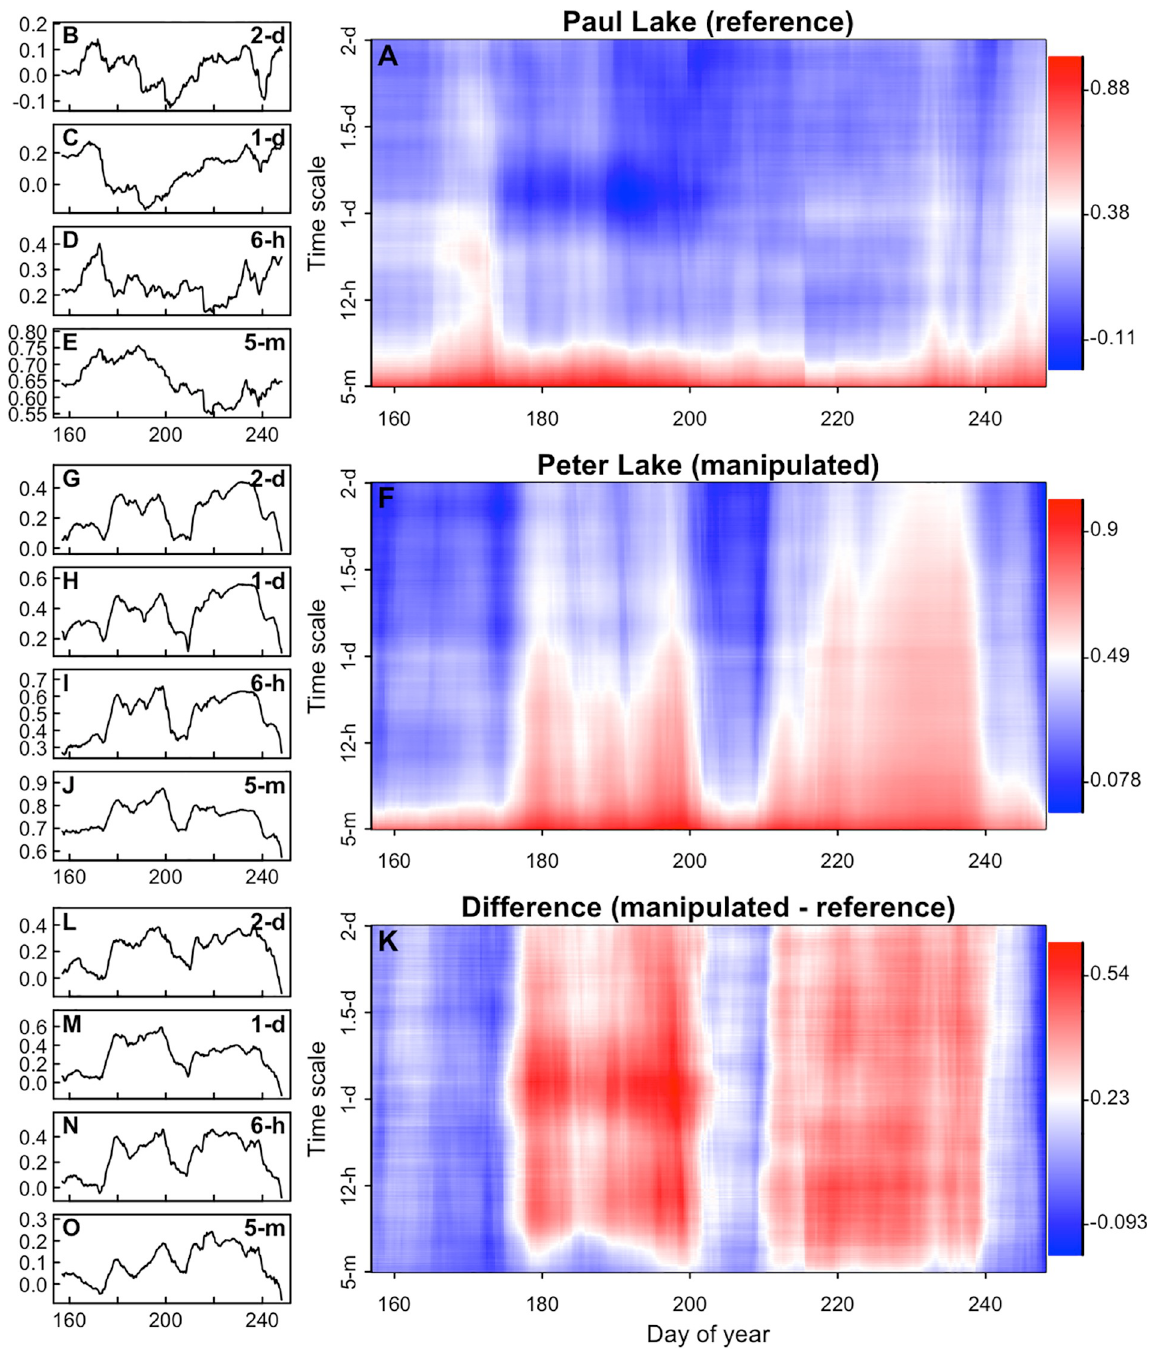
Fig 6. Autocorrelation of chlorophyll over time and across time scales. Panels A,F, and K indicate the autocorrelation (color) of the time series across time scales (vertical axis) through time (horizontal axis). Autocorrelation was computed by calculating the autocorrelation function in a rolling window (see Methods). Panel K is produced by subtracting Panel A from Panel F. Each of the time series panels to the left indicates autocorrelation dynamics at a single time scale. These panels use the same horizontal axis as panels A,F, and K, but represent autocorrelation on the vertical axis instead of as a blue-white-red color